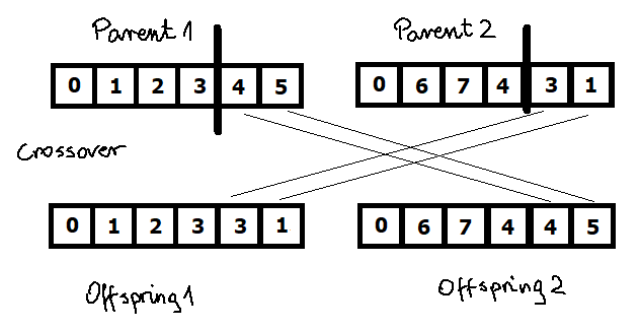
Figure 3. Simple crossover operation for VRP integer